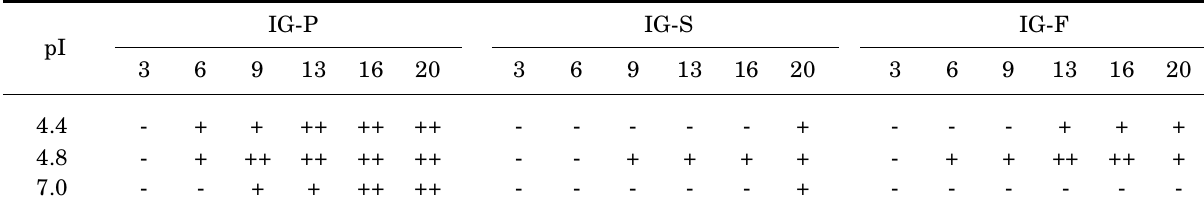
Table 3. Extracellular pectin lyase isozymes produced by the intersterile groups (IGs) P, S and F of